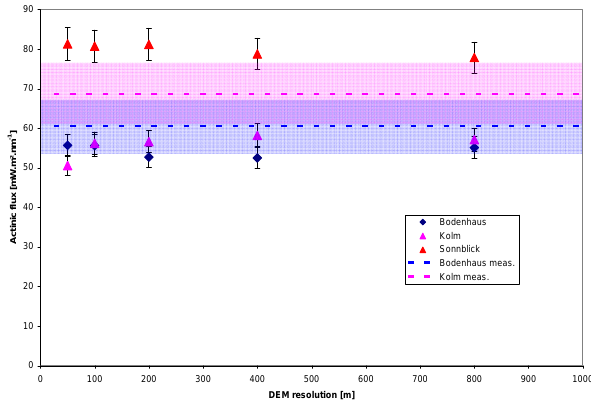
Fig. 16. Modeled 3-D UV Actinic (305nm) calculations for 7 May, 12:00UTC as a function of DEM resolution. Dotted lines show the Figure 16: Modeled 3-D UV Actinic (305 nm) calculations for 7 th May, 12:00 UTC as a measurements which correspond to the locations and the time of function of DEM resolution. Dotted lines show the measurements which correspond to the calculation. Solar zenith angle is 32.77 degree. The shapes show the locations and the time of calculation. Solar zenith angle is 32.77 degree. The shapes show the model results (diamond=Bodenhaus, square=Kolm Saigurn, trian- model results (diamond = Bodenhaus, square = Kolm Saigurn, triangle = Sonnblick). The gle=Sonnblick). The error bars show the accuracy of the model simulations ( ± 5%). The coloured areas around the lines of mea- error bars show the accuracy of the model simulations (±5%). The coloured areas around the surements indicate the measurement uncertainty ( ± lines of measurements indicate the measurement uncertainty (±10%).